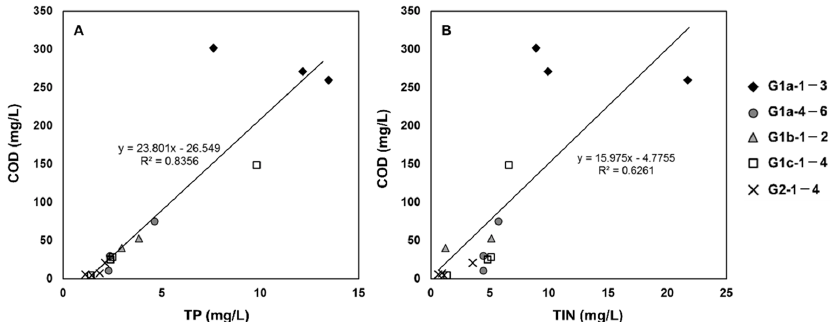
Figure 7. Relationship between COD (chemical oxygen demand), TP (total phosphorus), and TIN (Total inorganic nitrogen) concentrations in the Galing River.